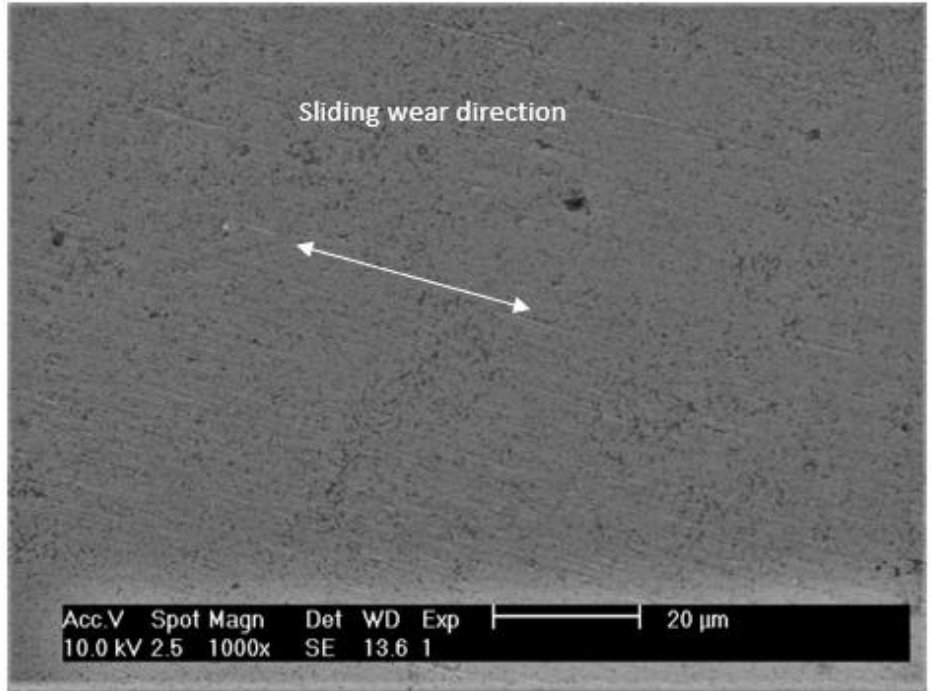
Figure 14. SEM micrograph showing the preferential direction of striations or ploughing that are parallel to the sliding direction for the system WC-AISI 304/Al 2 O 3 . SEM micrographs of the wear track for the system composed by WC-Co/Al 2 O 3 shows a com- pletely different behaviour as illustrated in Figure 15. It is possible to observe a dense and homoge- neous layer of oxides that covers the entire wear track. Figure 16 shows a micrograph of the border area between the wear track and unworn area while Figure 16b – f shows the respective chemical composition of the different elements obtained by EDS, confirming the presence of a dense layer of oxides.